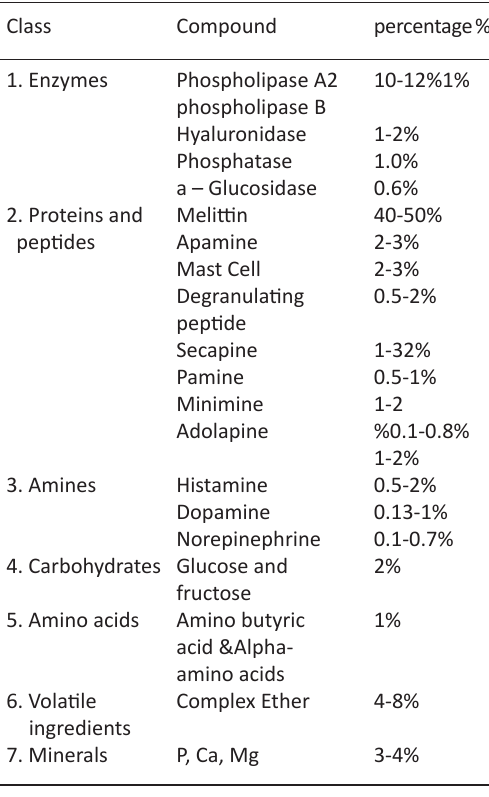
Table 2. Composition of Bee Venom and its percentage